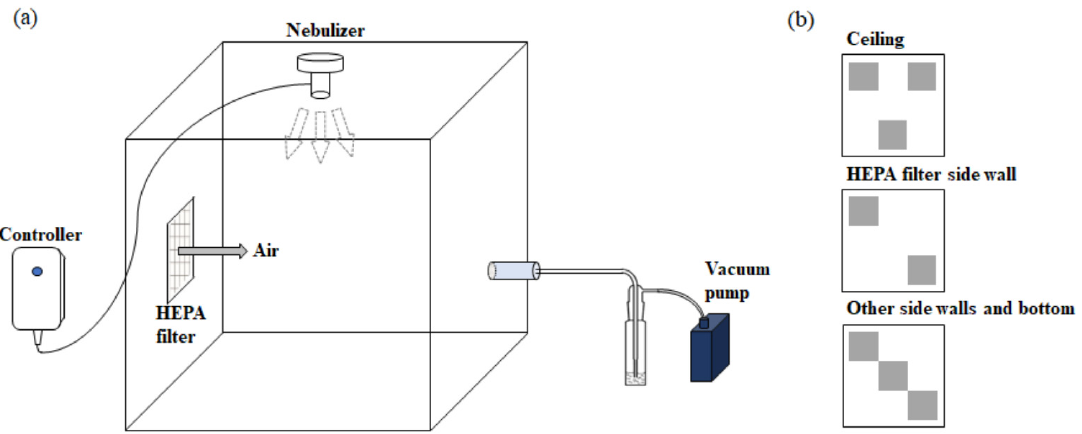
Figure 2. ( a ) Chamber setting for sampling aerosolized biocides with aluminum foil. ( b ) Setup of the aluminum foils (10 × 10 cm) on each side of the chamber.